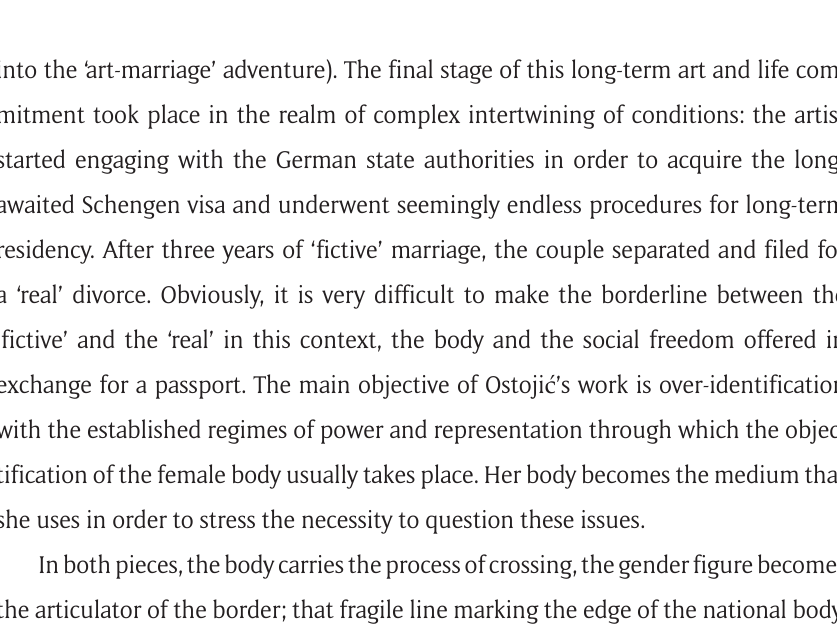
Figure 2: Tanja Ostojic Looking for a Husband with an E.U. Passport 2000–05 photos: Rasmus Jurkatam